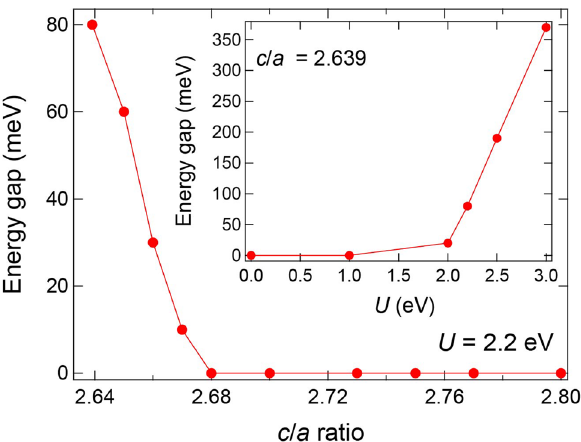
Figure 6. Lattice deformation induced MIT from DFT calculation. Plots of the energy gap at E F from DFT + U calculations with U = 2.2 eV as a function of c / a ratios. The inset shows plots of the energy gap at E F in bulk Ti 2 O 3 ( c / a = 2.639) as a function of U